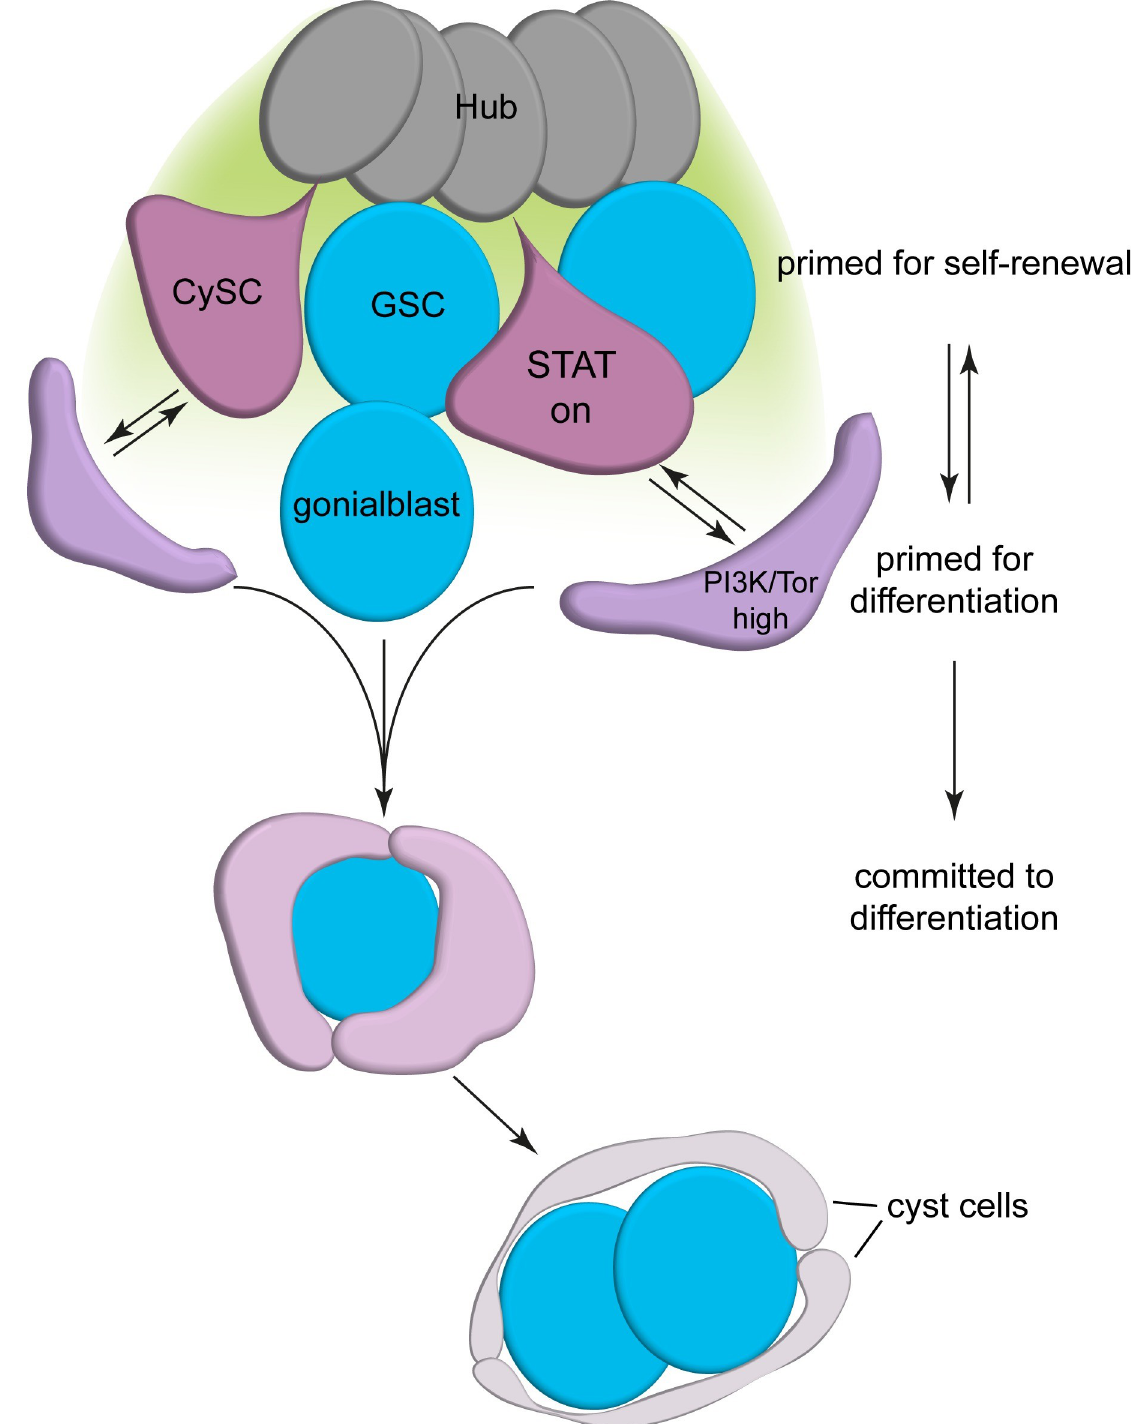
Fig 7. Model of CySC differentiation. CySCs (purple) at the hub (dark grey) receive self-renewal signals (indicated by a green gradient) and are primed for self-renewal. Upon losing access to the hub and experiencing increased PI3K/Tor activity, CySC daughter cells become primed for differentiation, and can interact with goniablasts that arise from GSC divisions. Differentiation priming is reversible, and cells with high PI3K/Tor maintain stem cell potential. Upon interaction with a gonialbast, a cyst forms and the cells co-differentiate.